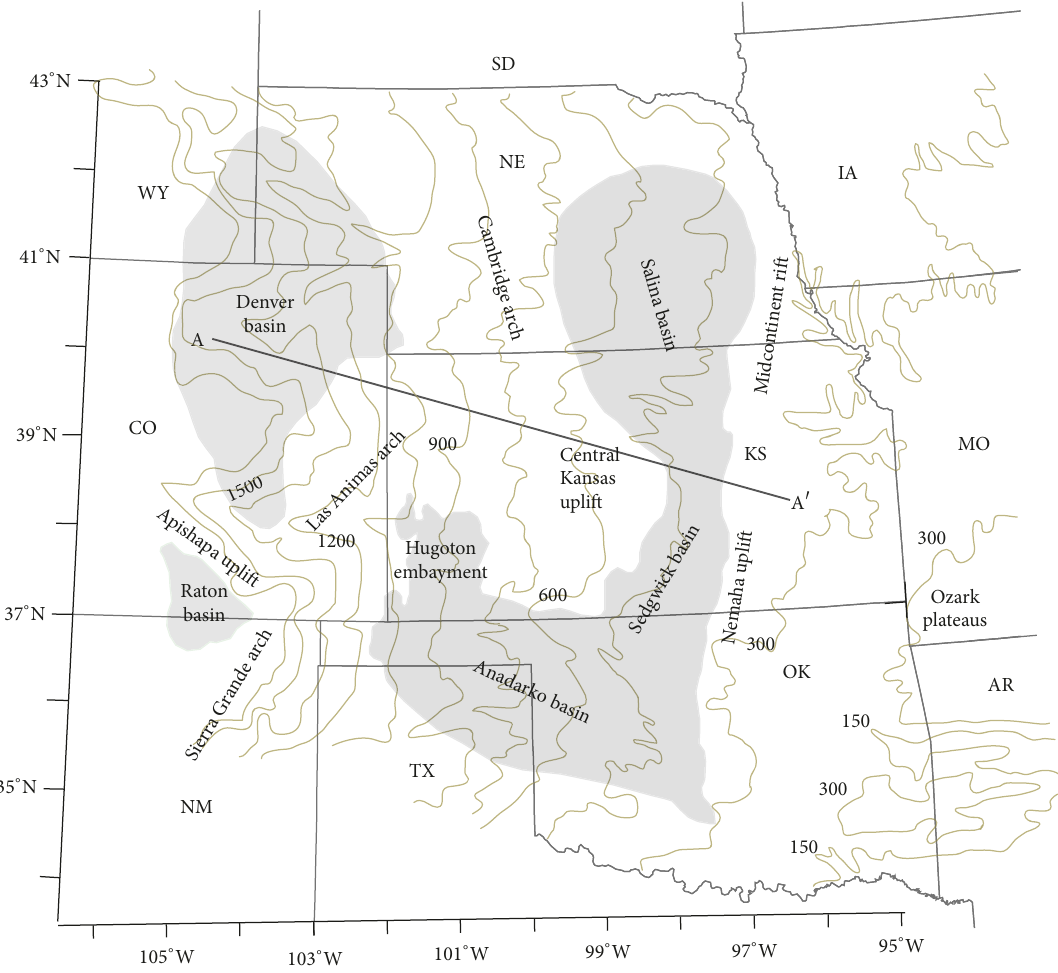
Top and bottom of confined aquifer with measuring point in center Figure 1: The definition of underpressure. 𝐷 , depth of measuring point; WT, elevation of water table; GL, elevation of ground level; Up real, actual underpressure as head drop; Up approx, head drop from land surface; 𝑝 , pressure; 𝛾 , unit weight of water; 𝑍 , elevation of formation.